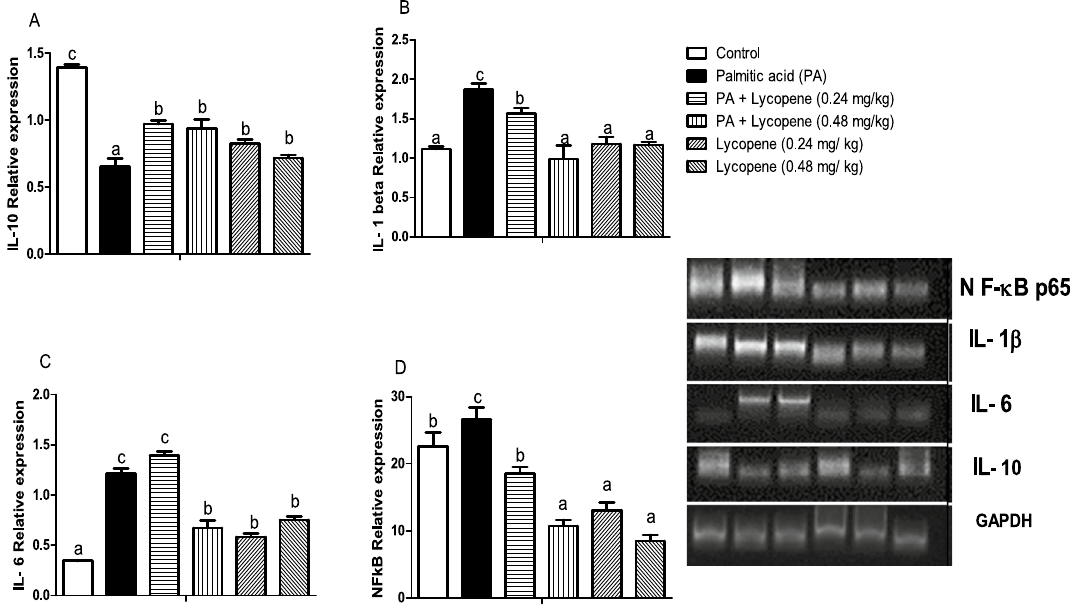
Figure 5. Effects of lycopene on the inflammatory gene expression levels of palmitic acid-induced neuro- inflammation in female rats. Values are expressed as mean ± S.E.M (n = 5). Bars with different letters are statistically distinct (p < 0.05). ( A ) Interleukin- 10 level ( B ) Interleukin 1- beta level ( C ) Interleukin -6 level ( D ) NF-kB level. Data were analysed using SPSS version 20 (IBM SPSS Software, United Kingdom) while the graph was plotted using GraphPad Prism Software, version 6 (San Diego, CA 92,108). https:// www. graph pad. com/ scien tific- softw are/ prism. The agarose gel intensity was quantified using Image J, Version 8. (https:// github. com/ imagej/ image j1).